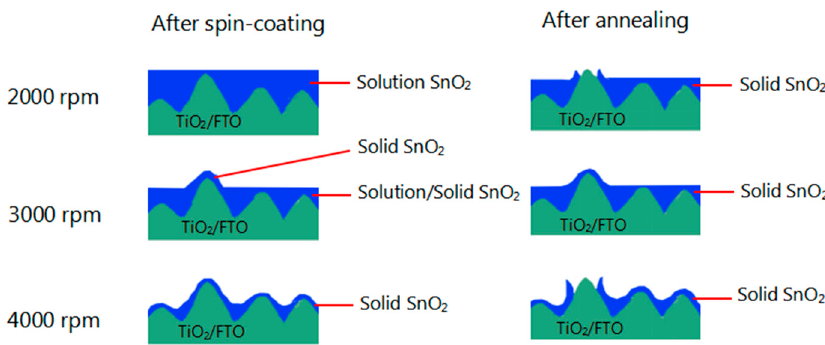
Figure 3. Schematics for formation of SnO 2 thin films at different rotational speed.